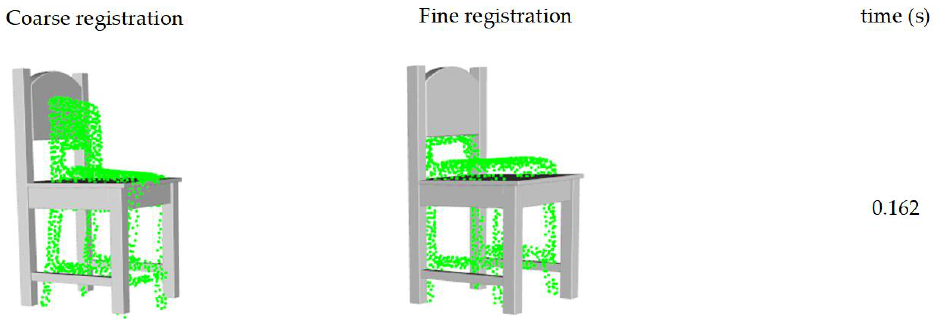
Figure 14. Model-to-scene fine registration.